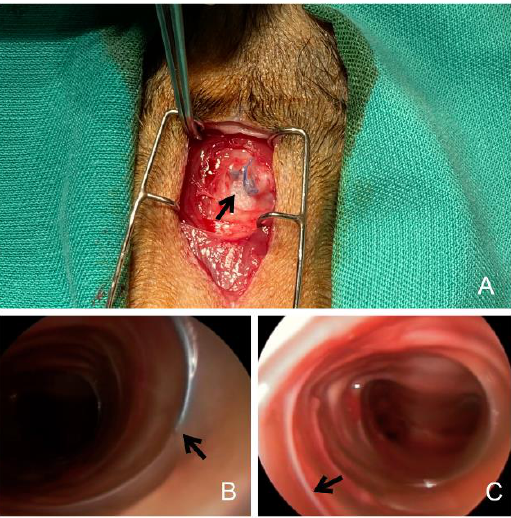
Figure 2. ( A ) Suture fixation of the MSS to the tracheal cartilage. ( B ) Unscrewing of the MSS. This visualizes how the prosthesis can be extracted without damaging the tissue. ( C ) White imprint after MSS removal. MSS: Metallic spiral stent.